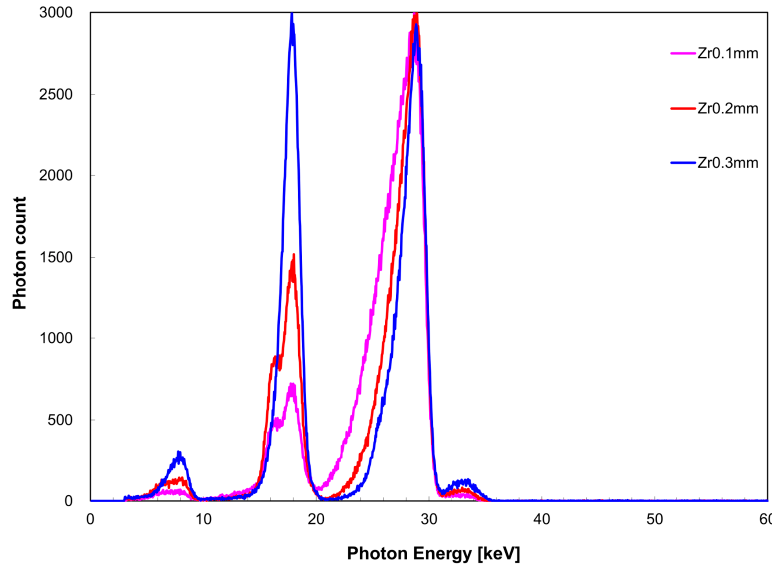
Figure 6. Zirconium filter thickness dependence of X-ray spectrum when the tin filter thickness was 0.2 mm.